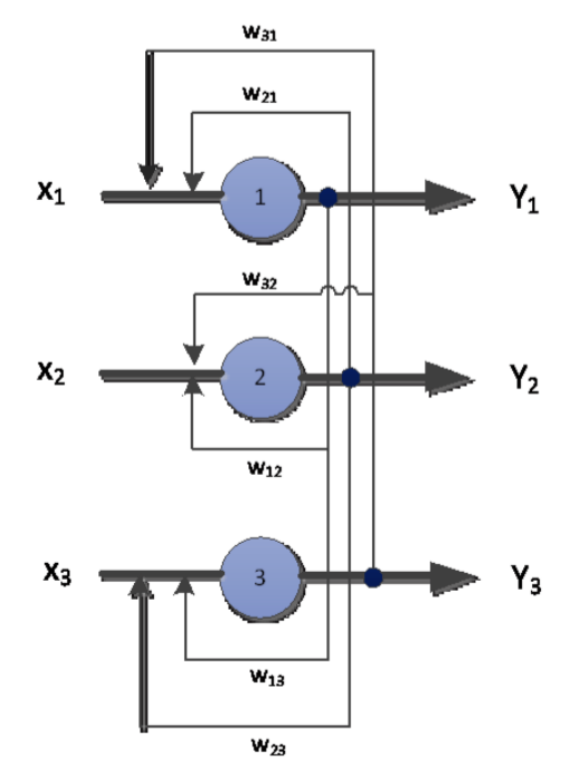
Figure 2: The scheme of feedbacks in Hopfield neural network